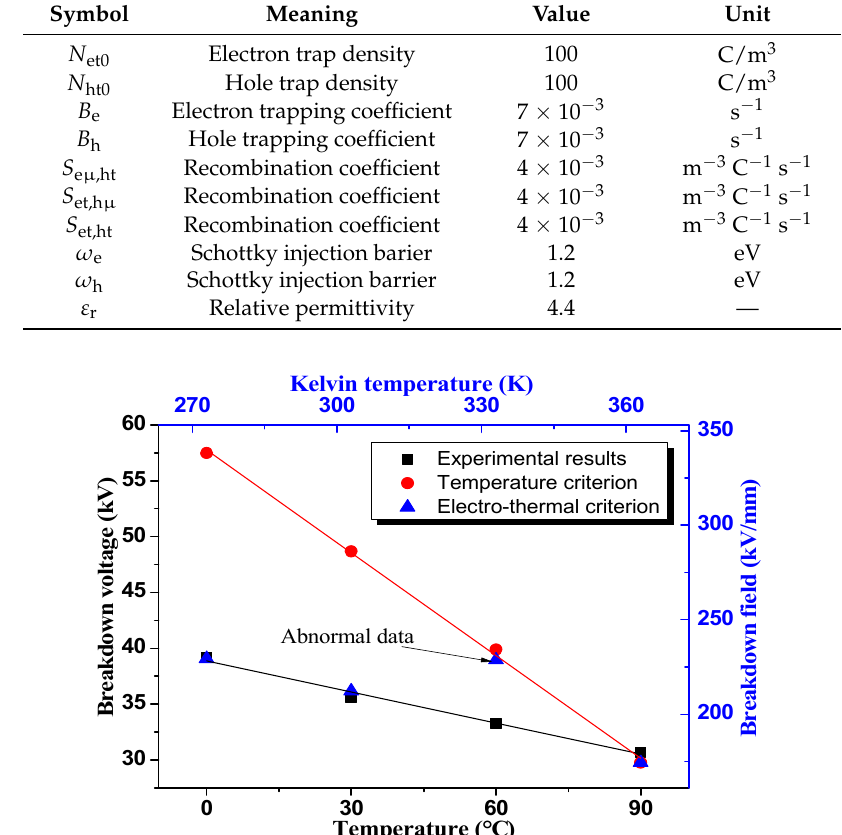
Table 2. Parameters for bipolar charge simulation.